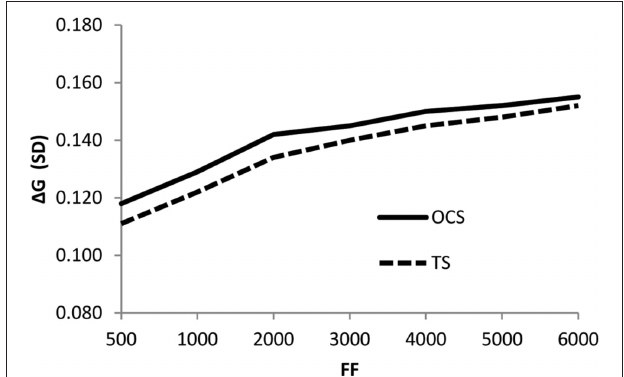
FIGURE 2 | Annual genetic gain ( (cid:49) G) (standard deviation units) with optimum contribution selection (OCS) and truncation selection (TS) in populations from 500 to 6,000 females (FF) with inbreeding control (Gandini et al.,